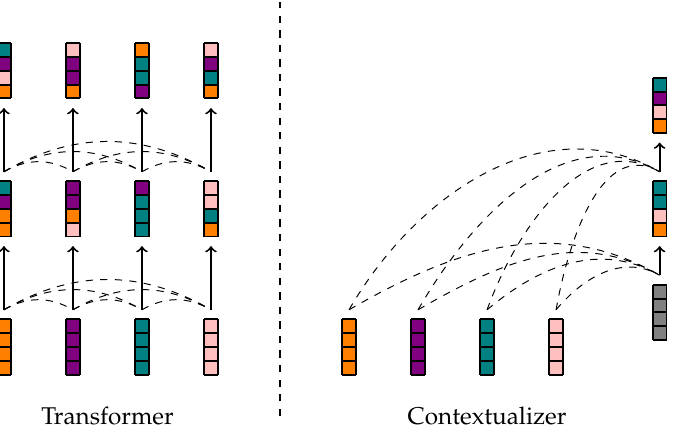
Figure 1. The Transformer encoder updates the representations of tokens with respect to each other over a set number of steps by letting each token attend over all tokens in the sequence. This amounts to a distributed representation of the context. The proposed approach updates a single context vector which attends over the tokens at